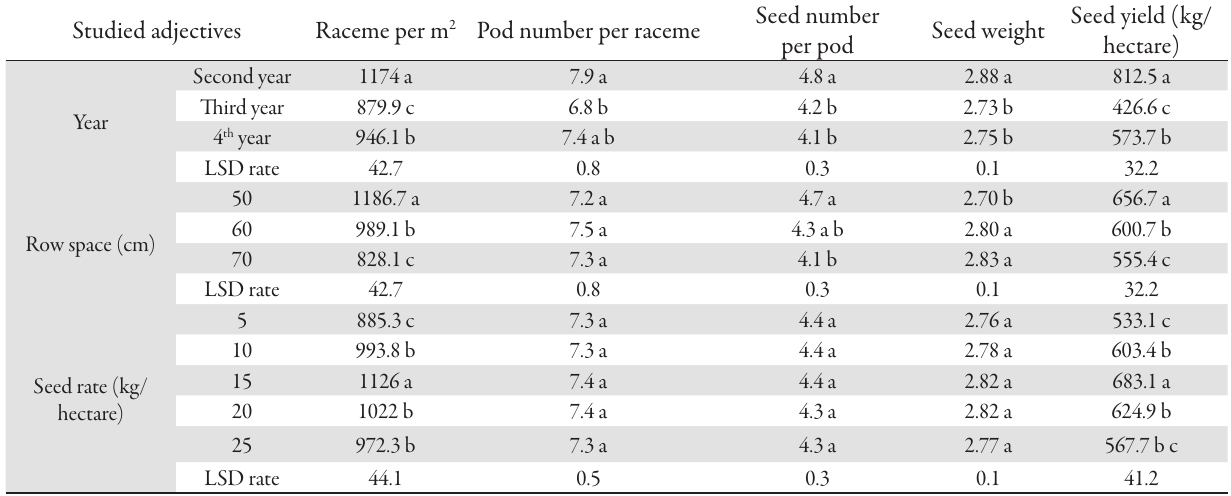
Tab. 4. Comparing yield component averages and Alfalfa seed yield of ‘Mesasirsa’ figure during experimental years and row space and seed rate